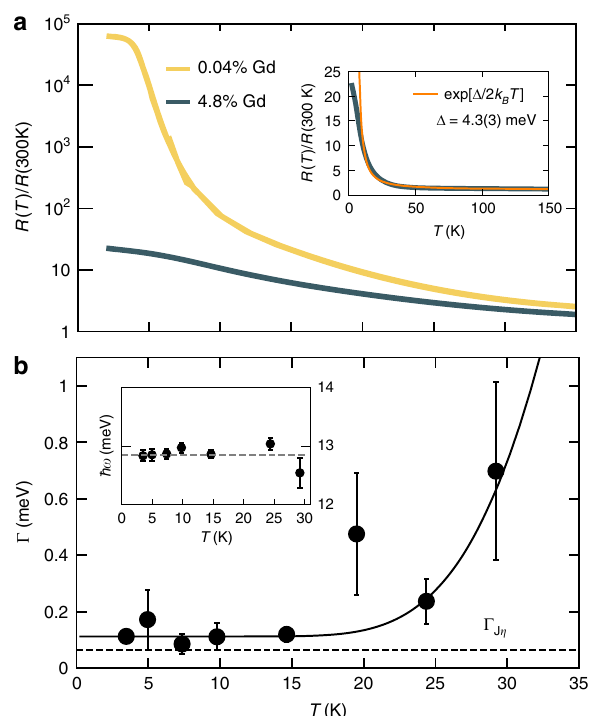
Fig. 3 Normalized resistance and exciton lifetime. a Resistance of 4.8% Gd-doped (5.5 × 1 × 1 mm 3 rod) and isotopically puri fi ed 154 Sm 11 B 6 (2 × 2 × 1 mm 3 chip). In the doped sample, R(T) increases monotonically with decreasing T. Inset shows R(T) for the 4.8% Gd sample on a linear scale, which above 10 K fi ts to an exponentially activated form with a gap of 4.3(4) meV (orange line). b Spin-exciton lifetime and mode energy (inset) vs T . Solid line shows Γ 0 þ A exp ð(cid:2) Δ = k B T Þ ), with non-thermal lifetime Γ ¼ 0 : 11 meV and temperature dependence from exponential activation to 0 the mode energy Δ = 12.8 meV). Dashed line is the lifetime estimated from coupling the collective mode to a DOS at EF ( Γ J η ¼ 0 : 080 meV). Error